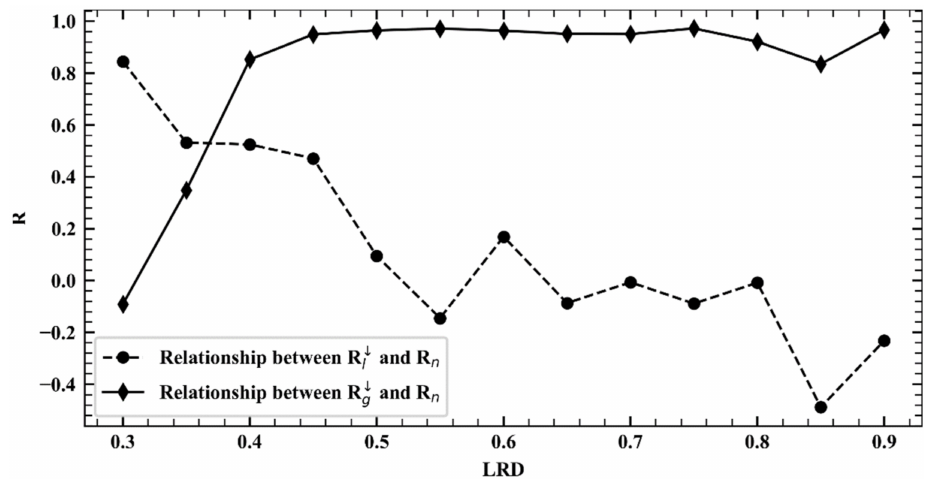
Figure 2. The correlation between R n and R ↓ g and R ↓